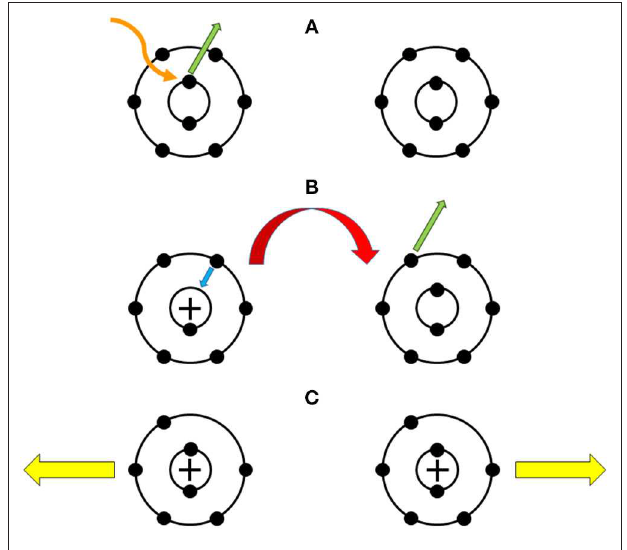
FIGURE 6 | (A) Photoionization of a neon dimer, via ejection of an inner shell electron from an atom (green arrow), due to incident x-ray radiation (orange wavy line). (B) Interatomic Coulombic decay: an outer electron relaxes into the vacancy (blue arrow) and, consequently, photo-ionization of the other atom occurs due to energy transfer between the atoms (red arrow). (C) The newly charged atoms (plus signs) repel each other (yellow arrows), which results in destruction of the neon